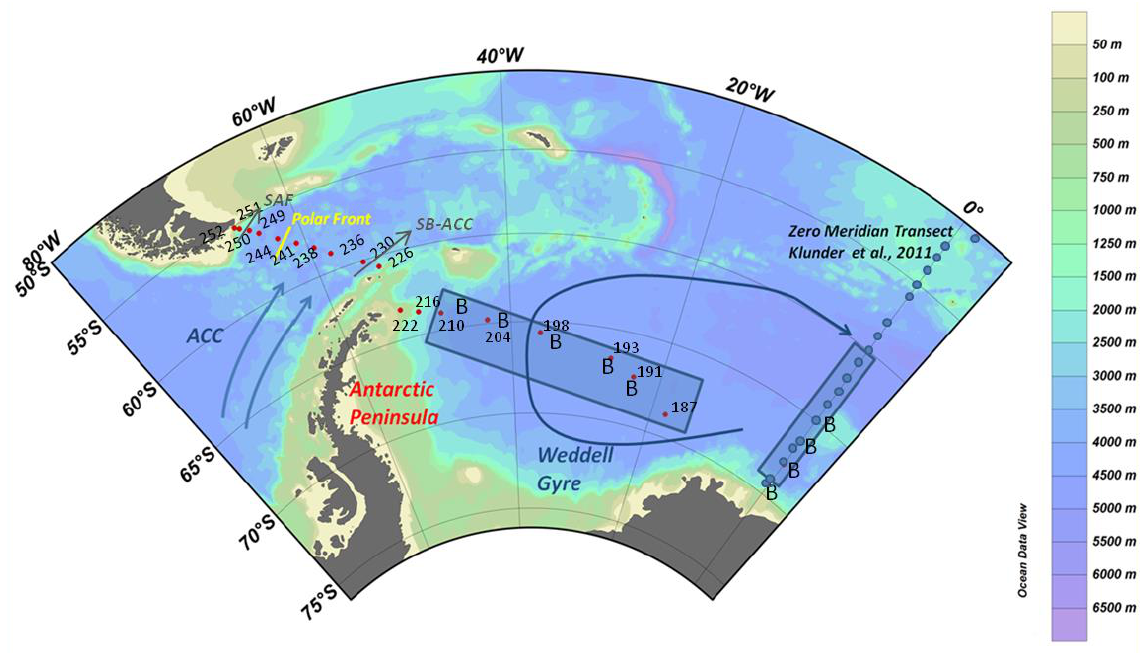
Fig. 1a. Sampling region including Weddell Sea and Drake Passage stations (red dots). Also shown are the general flow directions (blue arrows) of the Weddell Gyre and Antarctic circumpolar current (ACC) and the subantarctic front (SAF) at 55.6 ◦ S in the northern and the southern boundary of the ACC (SB-ACC) at 60.4 ◦ S in the south (both greyscale). Within the ACC, the polar front (PF) is found at 57.3 ◦ S (yellow)). The westward geographic boundary of the Weddell Sea is the Antarctic Peninsula up to Elephant Island, the traditional eastward boundary at Cap Norvegia (12 ◦ W). Please be aware that the Weddell Gyre extends far more eastwards to ∼ 20 ◦ E. The blue shaded boxes show the stations for which nutrient removal is calculated (see main text; Figs. 6 and 8). Stations for which biological (phytoplankton) data is available are marked with a “B” (see text). The stations from the transect over the zero meridian (Klunder et al., 2011a) are marked as blue